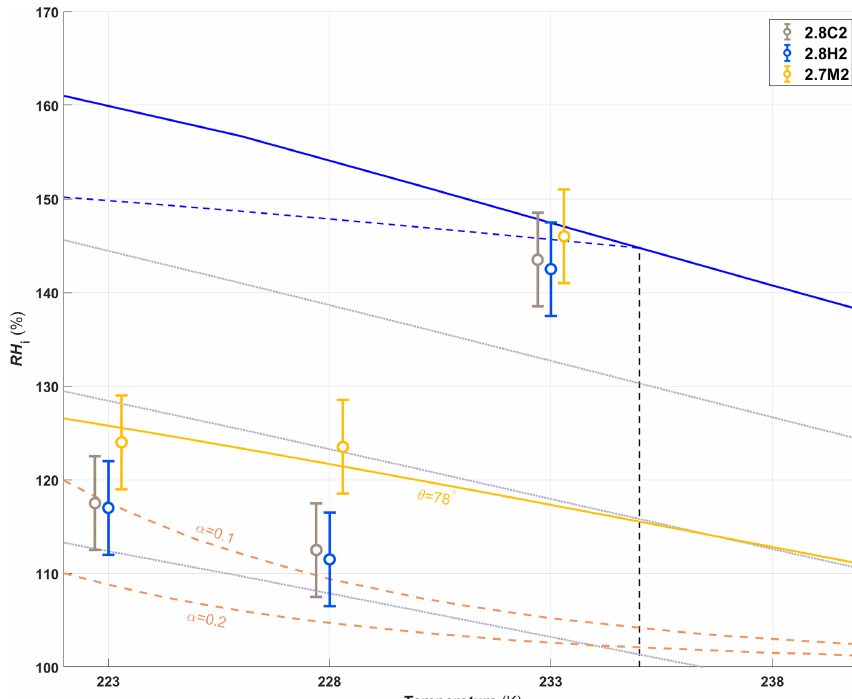
Figure 6. The average RH i required for an AF 0 . 05 for the hydroxylated (blue), methylated (gold) and calcined (grey) porous (2.7–2.8nm) silica samples. The error bars represent the maximum uncertainty in the calculated RH i ( ± 5%) in ZINC arising from the uncertainty in the reported thermocouple temperature ( ± 0 . 1K; Stetzer et al., 2008) and encompass the standard deviation from averaging the experiments. The solid blue line and dotted grey lines represent water saturation and constant RH w decreasing in steps of 10% from the water saturation line, respectively. The dashed blue line is the homogeneous nucleation RH i based on Koop et al. (2000) assuming a nucleation rate of 10 8 cm − 3 s − 1 . The vertical dashed black line represents the homogeneous freezing temperature of pure water (HFT). The gold line denotes pore filling of 2.7nm wide pores assuming a water contact angle of θ = 78 ◦ . Pores of the hydroxylated and calcined samples are expected to fill well below ice saturation. The dashed salmon lines indicate the required RH i for ice to grow to a detectable size within the residence time of ZINC assuming an accommodation coefficient ( α ) of 0.1 or 0.2, respectively. Measurements were also conducted at 238K, but an AF 0 . 05 was not detected. The symbols of the calcined and methylated samples are offset by 0.3K colder and warmer, respectively, for